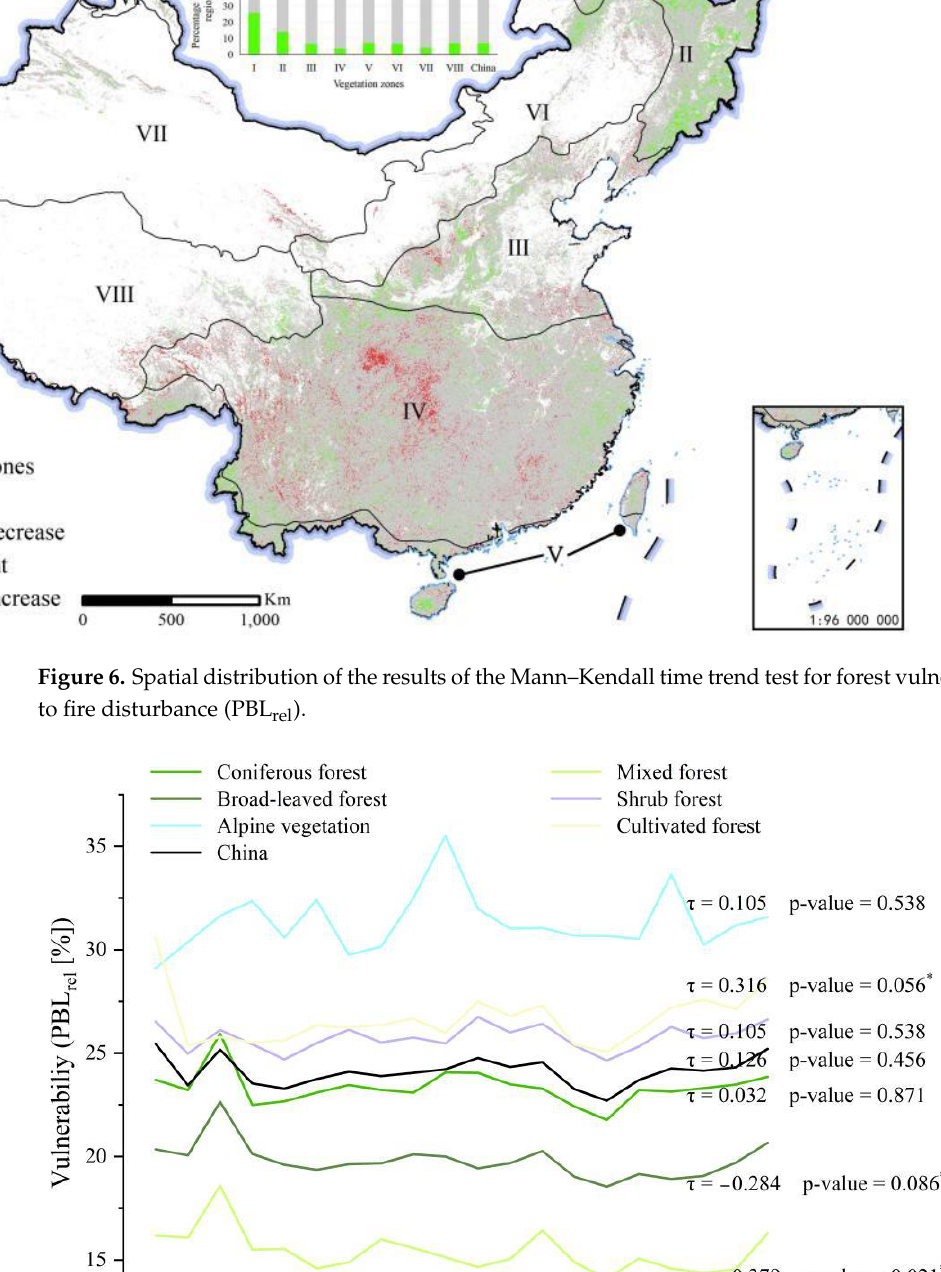
Figure 6. Spatial distribution of the results of the Mann – Kendall time trend test for forest vulnera- bility to fire disturbance (PBL rel ).